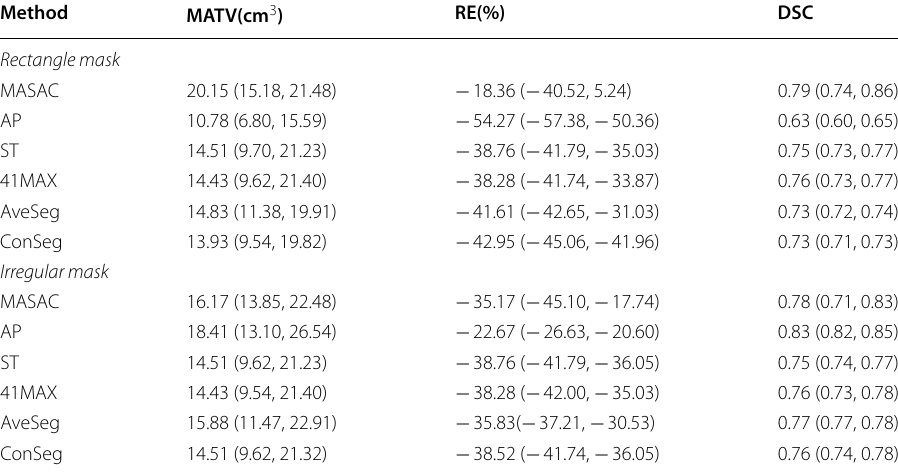
Table 3 Quantitative metrics used for assessment of the four individual segmentation methods, the average of four segmentation results (AveSeg) and the consensus method (ConSeg) for the simulated phantom studies including respiratory motion